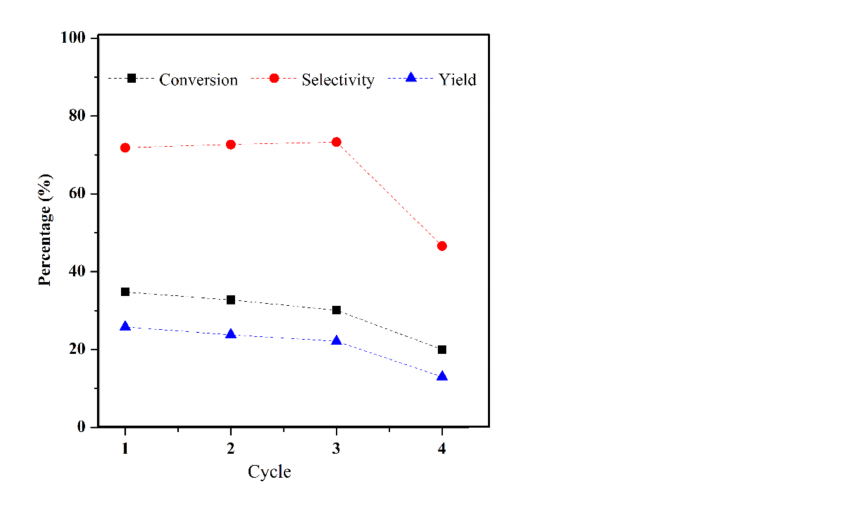
Figure 7. Regeneration and reuse catalyst in the catalytic performance of microwave-assisted glucose isomerization into fructose on 6Mg/NaX catalyst at 90 ◦ C for 15